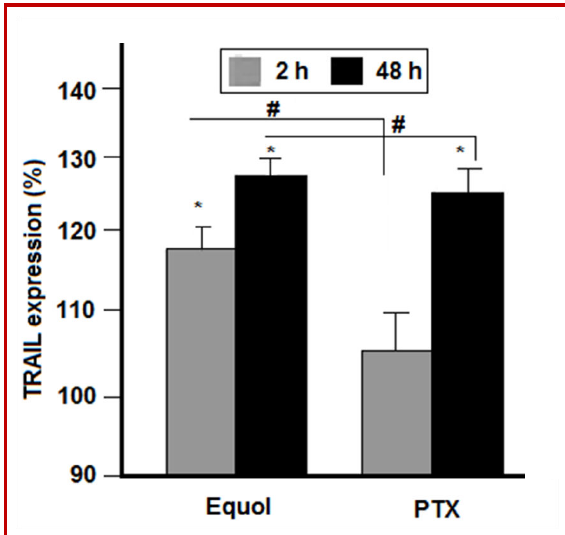
Figure 6: Effect of equol or PTX on TRAIL expression